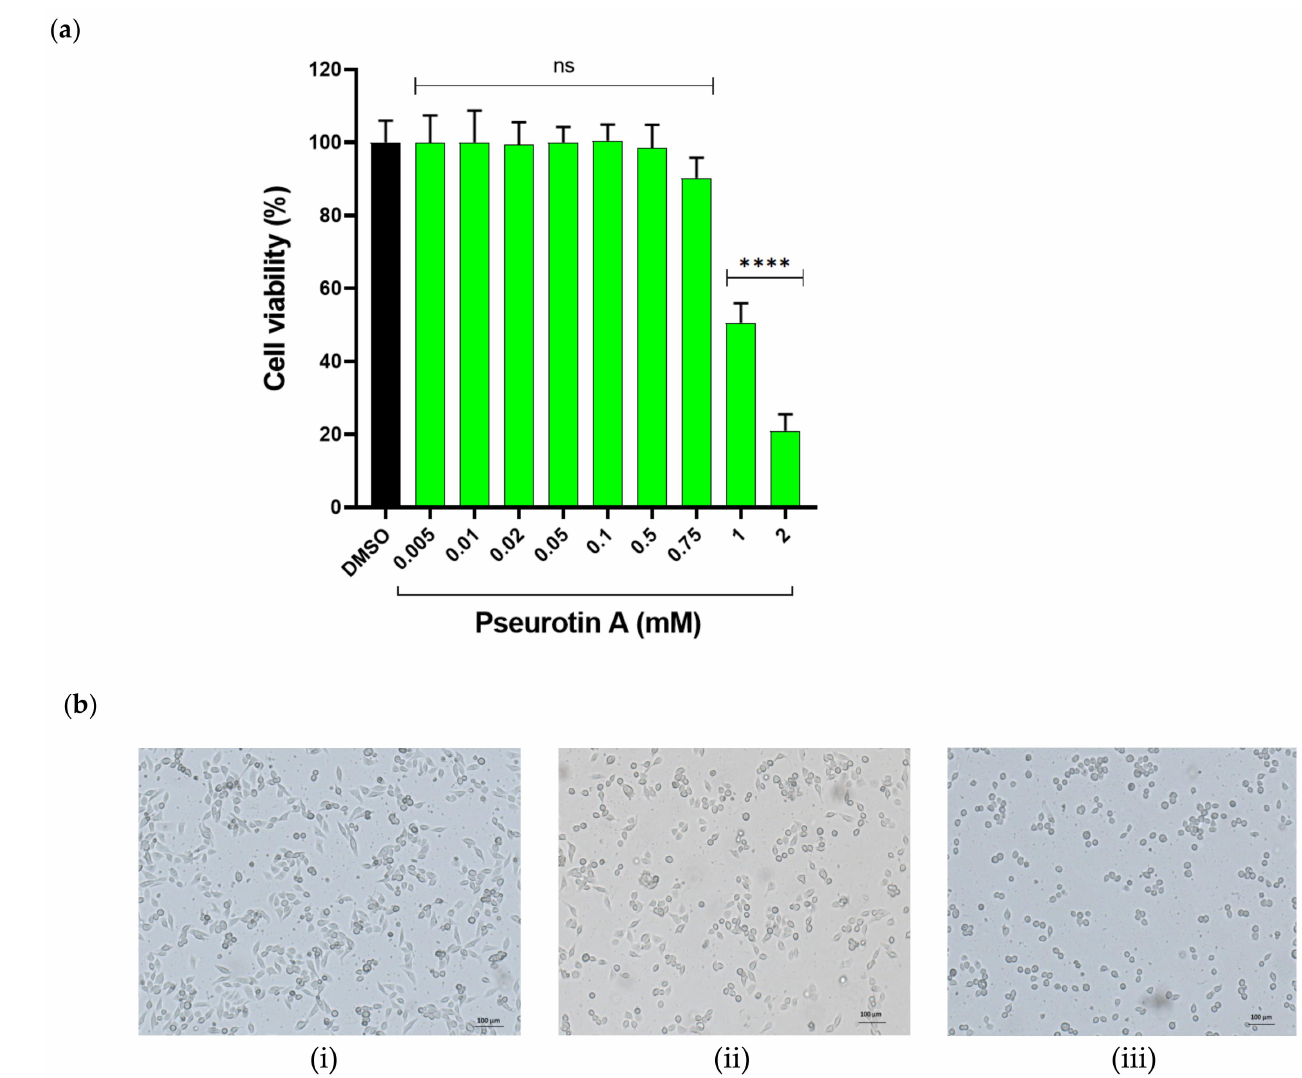
Figure 1. The effect of PsA treatment on the viability of the human immortalized RWPE-1 prostate epithelial cells determined by the standard MTT protocol. ( a ) Bar graph shows dose response of cytotoxic effect of PsA after 24 h treatment. ( b ) Representative images (scale bar embedded) of human immortalized RWPE-1 prostate cells. ( i ) DMSO treated control cells. ( ii ) Cells treated with PsA at 1 mM concentration. ( iii ) Cells treated with PsA at 2 mM level. Data shown as mean ± SD of triplicate wells. **** indicates a statistical significance at p < 0.0001 for specified concentrations versus vehicle-treated control cells. ns indicates non-statistical significance at p < 0.05.